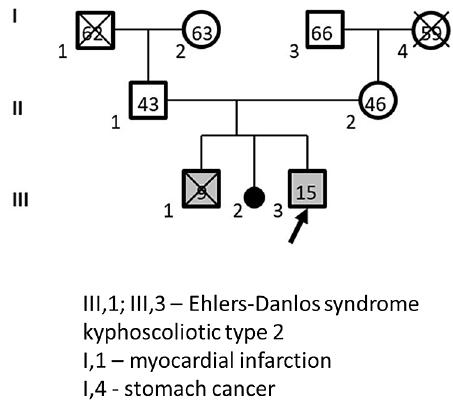
Figure 4. Pedigree of Proband no. 4, 15 years old. Roman numerals - generation number, Arabic numerals - family member number, numbers inside figures - family member's age, crossed out figures - deceased family